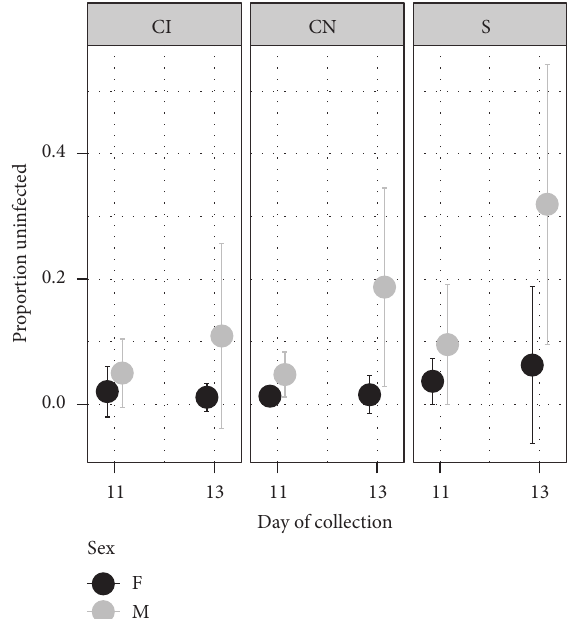
Figure 2: Graph (means ± 2 standard errors) of proportion uninfected progeny (untransformed data) for each selection regime × day × sex combination. Selective regimes included the following: CI (response to wounding), CN (the unperturbed control), and S (resistance to B. cereus infected). The significant interaction of day × sex is obvious, with male progeny having higher proportion surviving on the second day of eclosion compared to females across treatments.Again,thelinesselectedforresistanceto B.cereus tended to have the highest proportion of uninfected animals, and this trend was notably driven by the male progeny eclosing on the second day of